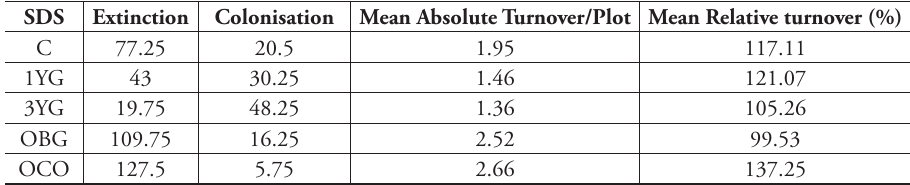
Table 6. Number of extinction and colonisation events (overall mean of the four subsamples at each plot), absolute and relative species turnover in the five stand developmental situations (SDS) based on resurvey data collected in 1996 and 2013. For explanations of the stand developmental situations, see